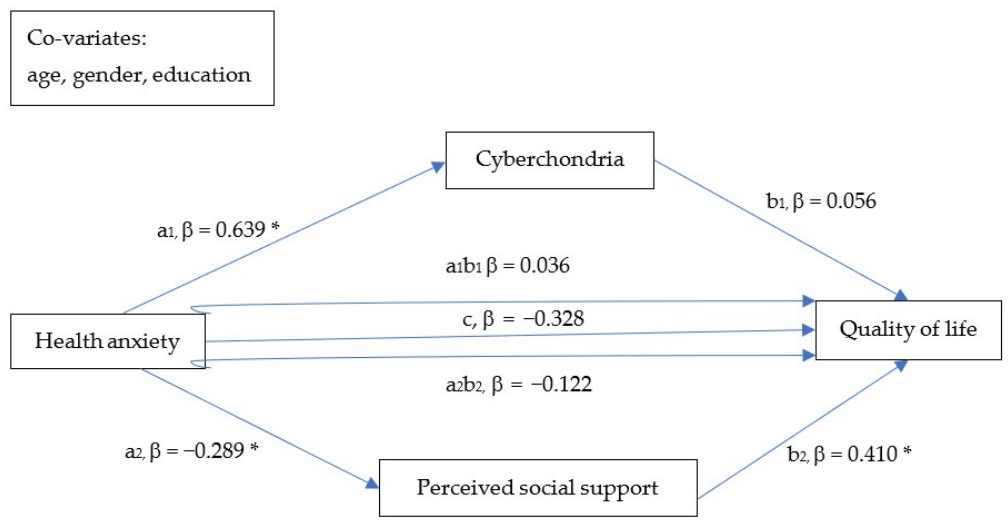
Figure 1. The multiple mediation model tested in the study. Significant effects (95% CI did not include zero) were marked with asterisks.